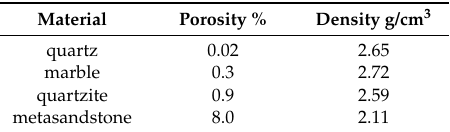
Table 1. Porosity and density of the raw materials